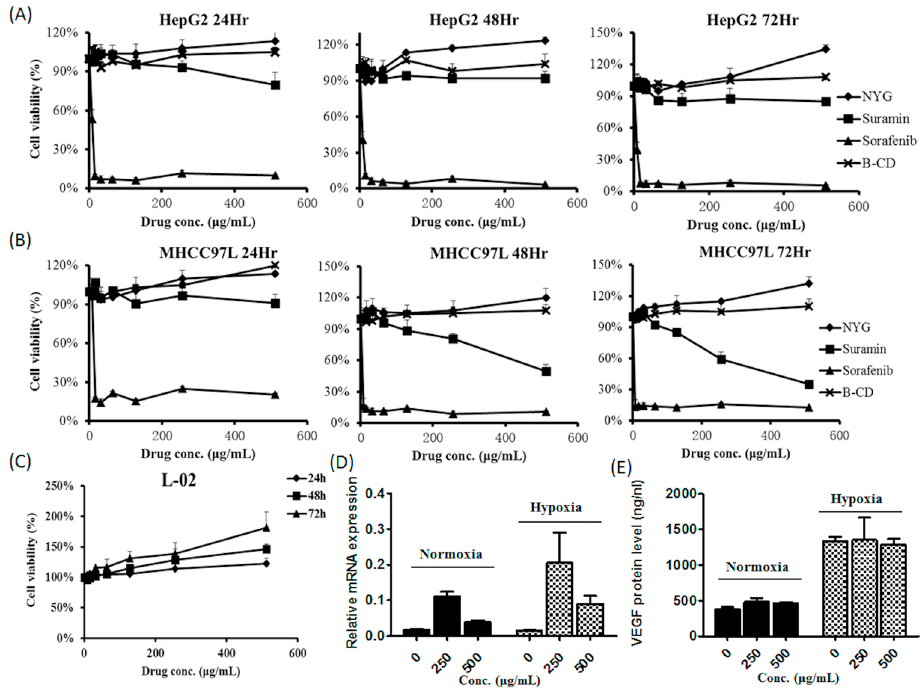
Figure 3. NYG exerted minimal effect on in vitro cultured HCC cells. ( A ) HepG2 and ( B ) MHCC97L cell lines were treated with NYG ranging from 0 to 500 μ g/mL at 24, 48 and 72 h of incubation. Beta-cyclodextrin (B-CD), suramin and sorafenib served as control groups. Cell viability were measured as average of replicates ( n = 3) with standard deviation (%); ( C ) The normal cell line L-02 was also treated with NYG in a dose and time dependent manner. NYG exerted no cytotoxicity on HepG2 and MHCC97L or L-02 cells; ( D ) The relative mRNA expression of VEGF in MHCC97L cells determined by qPCR. The VEGF mRNA was measured as fold change ± SD; ( E ) Amount of VEGF secretary protein of MHCC97L cells in both normoxia and hypoxia conditions. The VEGF concentration was measured as average ± SD (ng/nL). MHCC97L showed no significant changes in mRNA and protein concentration of VEGF after NYG treatment.